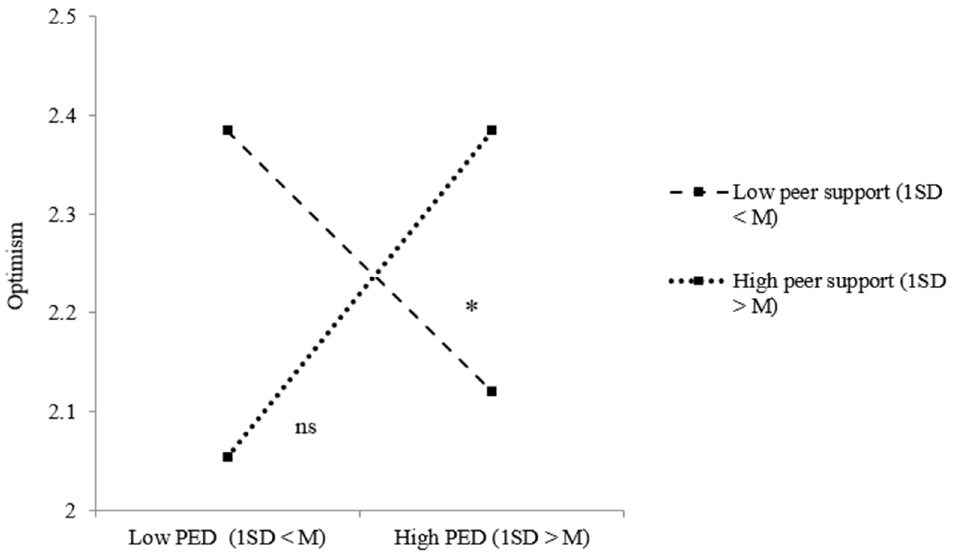
Figure 3. Effects of PED on refugee youth optimism dependent on the level of peer support. Note: * p < 0.05; ns = not significant.